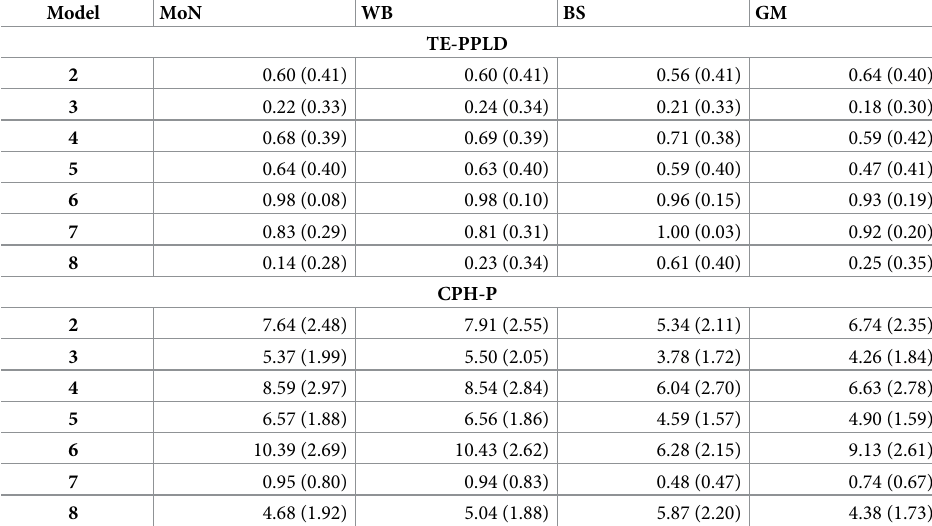
Table 5. Robustness to true underlying time-to-event distribution under H A .